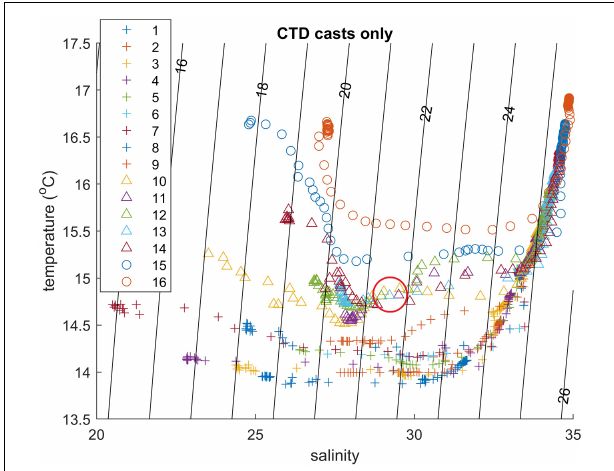
FIGURE 6 | TS diagram from CTD casts. Station numbers are shown in the legend; red circle emphasizes uniform TS properties of the buoyant layer between several stations.